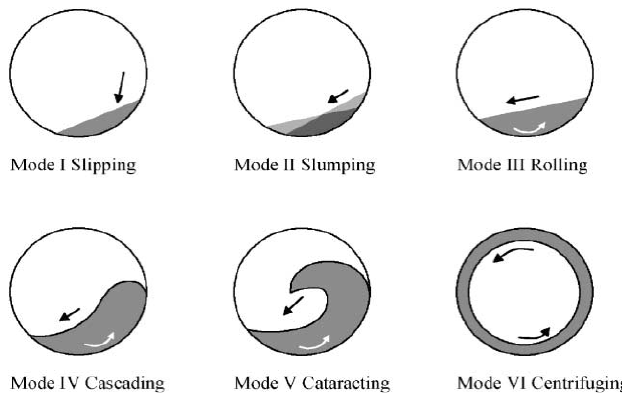
Fig. 1: Transverse motion modes of materials in a rotating cylinder ( K haZaei and g hanbari , 2010).